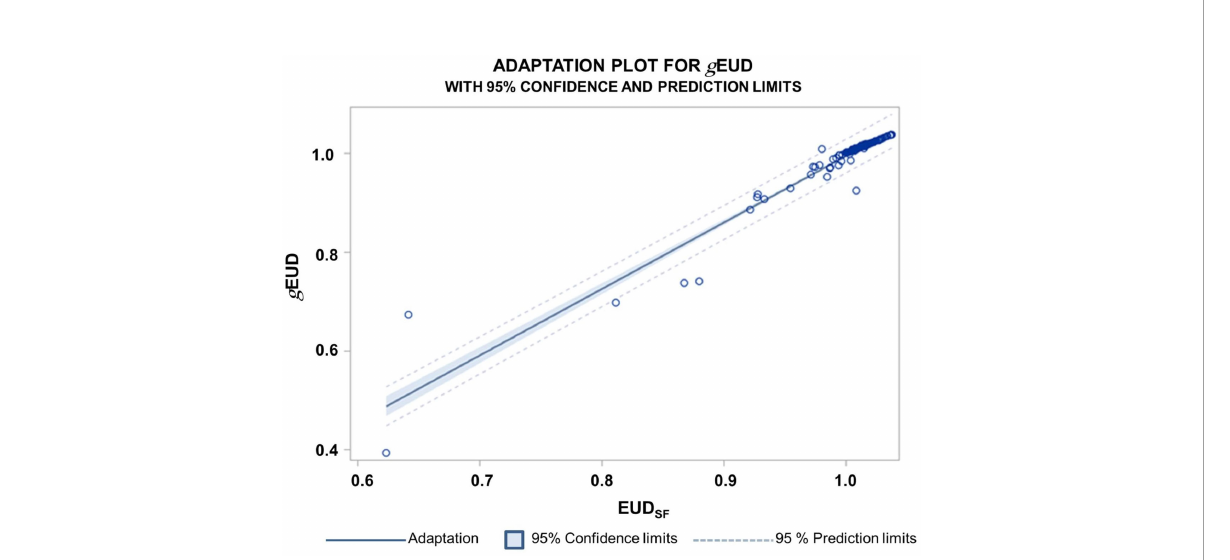
FIGURE 3 Relation between the g EUD normalized by the prescribed dose and normalized EUD SF values for the clinical PTV plans over all patients and all fractions. The normalized EUD SF values were calculated according to a cell survival model. The Spearman correlation coef fi cient was r s = 0.986; 95% con fi dence limits for the expected predicted values and for new predictions are